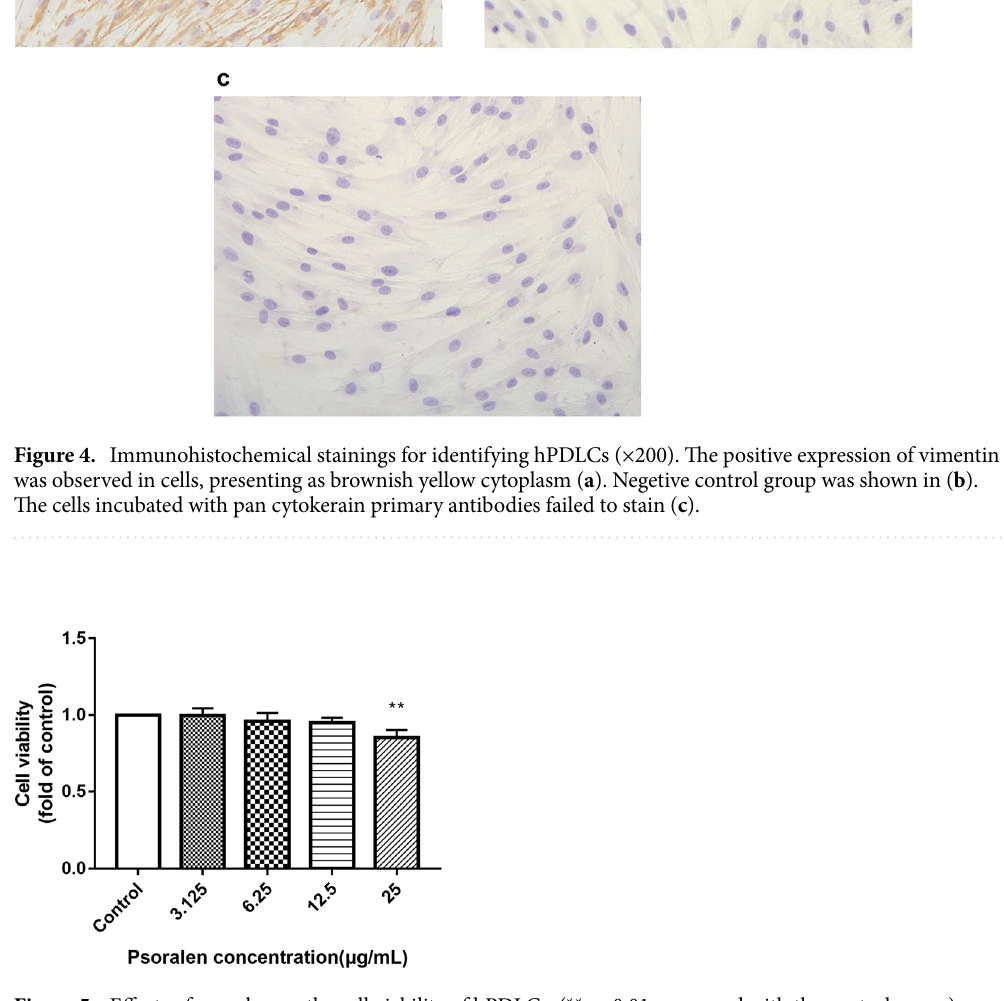
Figure 5. Effects of psoralen on the cell viability of hPDLCs. (** p < 0.01 compared with the control